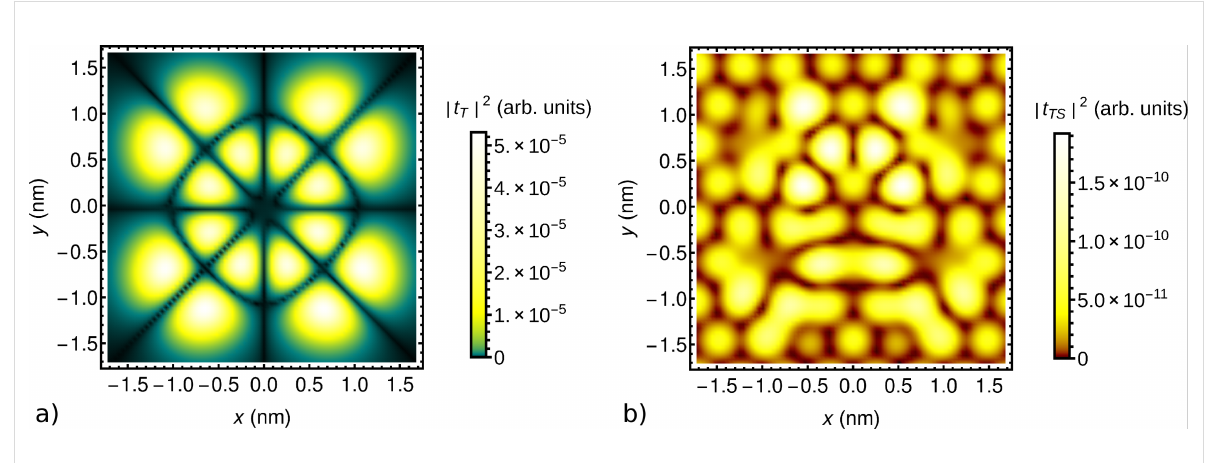
Figure 5: Absolute value squared of the tunneling amplitude a) between the STM tip and a CoPc HOMO on a graphene substrate and b) between the tip and a representative low-energy Bloch-type substrate state, as functions of the lateral position ( x , y ) for fixed height z = 0.64 nm.